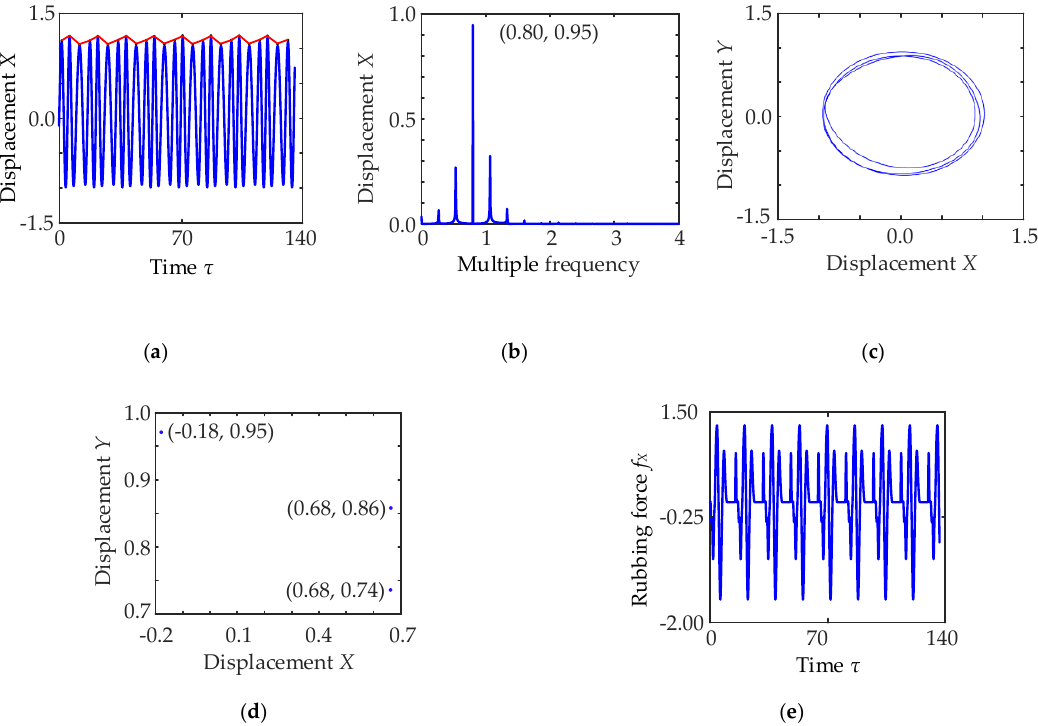
Figure 11. Rotor displacement when n = 10.7 krpm. ( a ) x - t ; ( b ) Amplitude spectrum; ( c ) Rotor trajectory; ( d ) Poincare mapping; ( e ) Rubbing force.